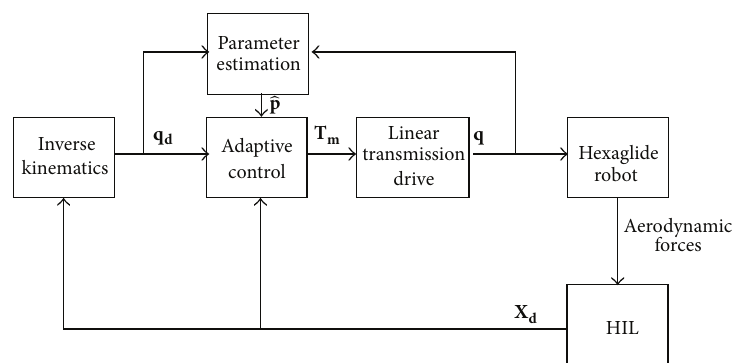
Figure 9: Block diagram of the adaptive-robust control for controlling the Hexaglide.